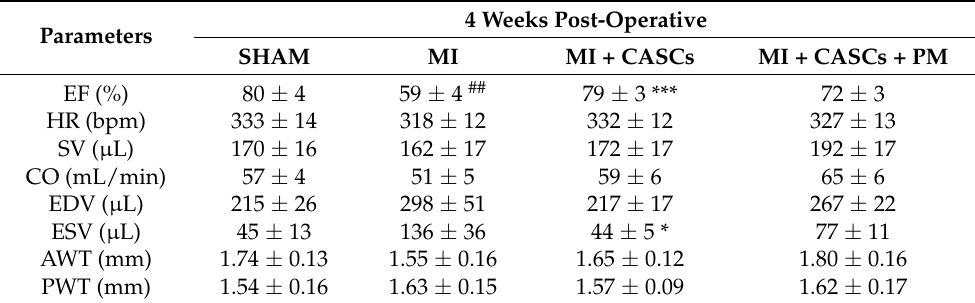
Table 1. Echocardiographic characteristics.